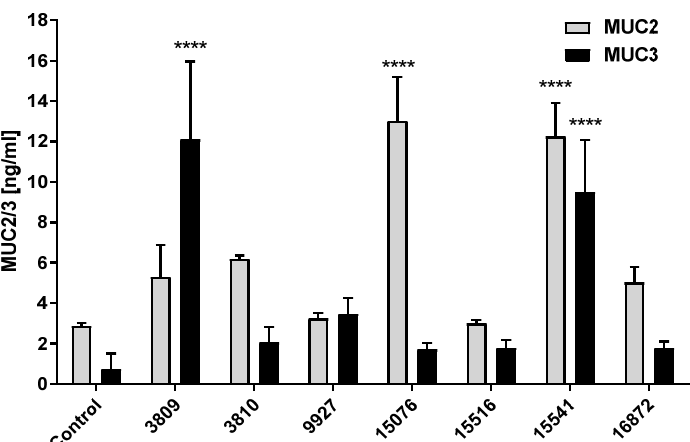
Figure 4. Mucin 2 and mucin 3 quantification in HT29-16E cells after treatment with seven Bacillus spp. strains. HT29-16E cells were incubated with the seven Bacillus spp. strains for 10 h. The cells’ supernatants were taken and mucin 2 (MUC2) production was measured in this fraction by ELISA. The cells were then detached with trypsin, collected and lysed by ultrasonication, and mucin 3 (MUC3) was measured in this cell fraction by ELISA. Data are expressed as mean ± SEM of two independent experiments performed in duplicates. Two-way ANOVA and multiple comparison tests were performed to assess statistically significant di ff erences between control and di ff erent probiotic treatments for MUC2 and MUC3, respectively. p -value ≤ 0.0001